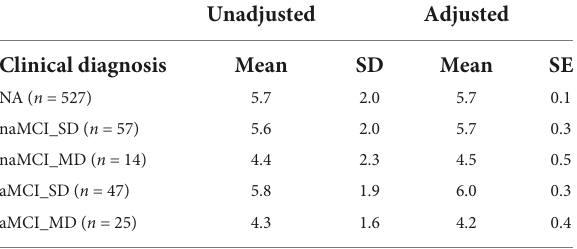
TABLE 3 Adjusted and unadjusted mean of smell identification score for different cognitive